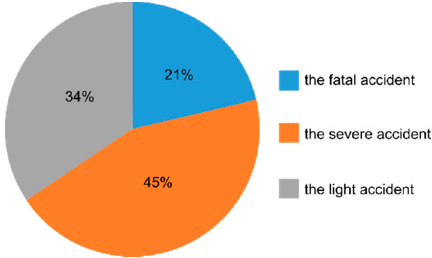
Figure 5. The result of an accident of people under the influence of alcohol on the basis of control protocols (own elaboration]).